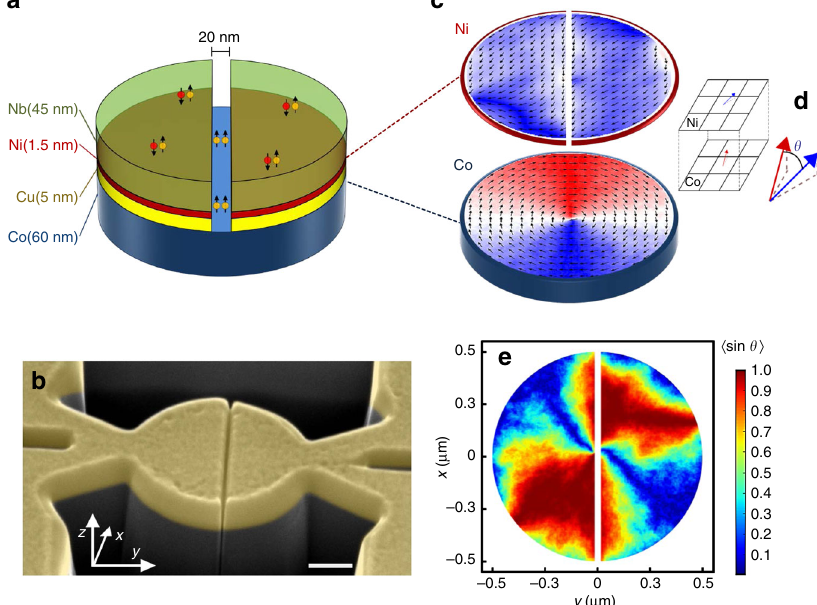
Fig. 1 Micromagnetic simulations and device layout. a Schematic of the device layout. b False-color scanning electron microscope image of a device. The scale bar corresponds to 250 nm. The disk is structured with Ga + focused ion beam (FIB) milling. The junction is formed by opening up a gap in the top Nb/Ni/Cu layers, leaving only Co in the weak link (see Methods section for more details). c Plane view of the magnetic states of Co and Ni layers in the disk (from 3D OOMMF simulations). The pixel color scheme, red-white-blue, scales with the magnetization along y . Magnetic moments in Ni tend to align with the gap which de fi nes the junction, while the vortex con fi guration in Co arranges the magnetic moments perpendicular to it. This provides a high degree of magnetic non-collinearity (MNC) for triplet generation. The curled magnetic structure of the vortex is also highly effective in minimizing the stray fi elds from Co, which otherwise would dominate the Ni magnetization, hence compromising our control of MNC. d Representation of our method to obtain the MNC pro fi le. For each cell at the top of the Co layer, we determine the angle θ between its magnetization vector and that of the Ni cell above. e Spatially resolved MNC pro fi le calculated from the simulation results shown in c . The observed suppression of MNC (the blue region) at the centre of the junction is a result of interlayer dipole coupling at the vortex